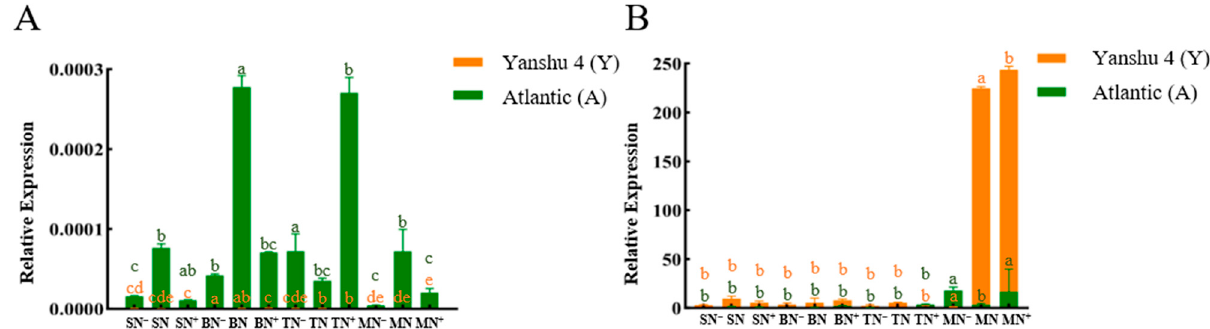
Figure 11. Relative expression of nitrate transporter StNRT1.5 in two genotypes of potato under different N supply levels. ( A ) Leaf (L); ( B ) Root (R). S, B, T, and M represent seedling stage, budding stage, tuber expansion stage, and mature stage, respectively. N − , N, N + are different N supply levels, representing low N, normal N, and excess N, respectively. Different letters indicate the difference of relative gene expression in different periods under different N application levels ( p < 0.05).